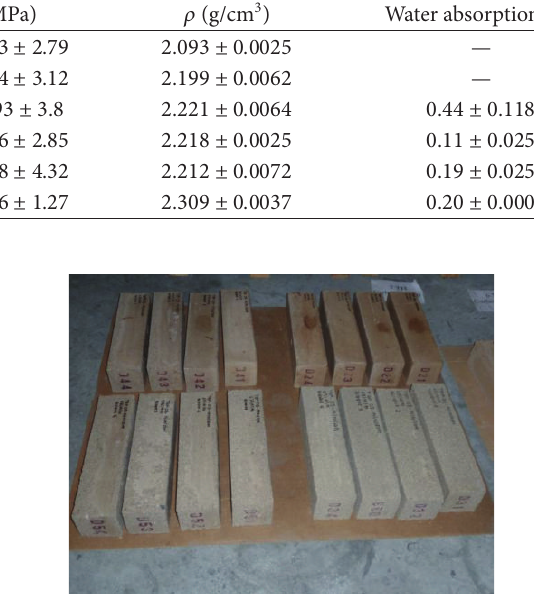
Figure 6: Specimens used for the flexural strength.